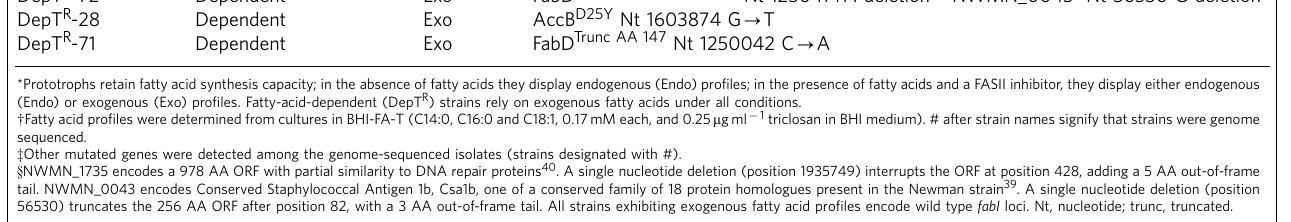
(Fig. 4b). In triclosan plus host organ extracts, growth of DepT R -5 (pJ-fabD) lagged slightly behind that of DepT R -5 (pJ) (Fig. 4c, Supplementary Fig. 5a). The intermediate effect could indicate that triclosan exerts a counter-selective effect on the plasmid- carried fabD copy.